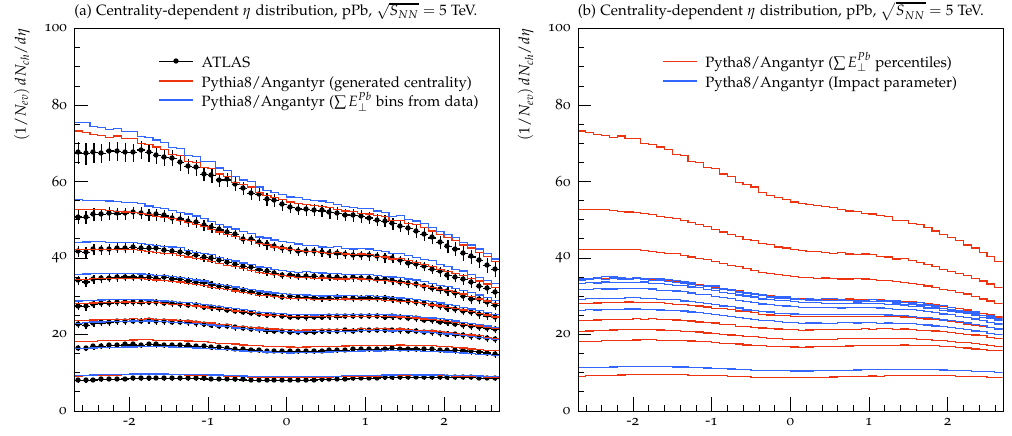
Figure 12 . Comparison between the average charged multiplicity as a function of pseudo rapidity in percentile bins of centrality for pPb collisions at p s = 5 TeV. In (a) data from ATLAS [26] is NN compared to results from Angantyr. The lines correspond to the percentile bins in (cid:12)gure 11 (from top to bottom: 0{1%, 1{5%, . . . , 60{90%). The red line is binned using percentiles of the generated E Pb , and the blue line according to the experimental distribution (cf. the table in (cid:12)gure 11). ? In (b) the red line is the same as in (a), but here the blue line uses percentile bins based on the P generated impact parameter in